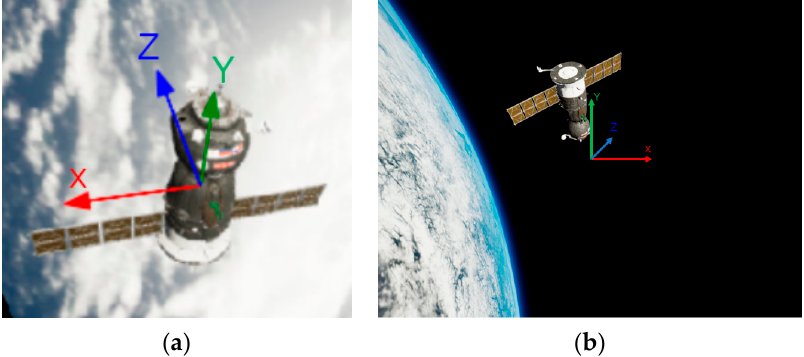
Figure 3. ( a ) Axis notation for a moving spacecraft frame, and ( b ) axis notation of the camera frame.